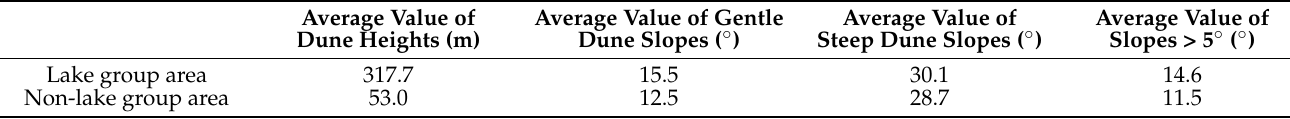
Table 2. Comparison between the dune heights and slopes in the lake and those in the non-lake group areas. Average Value of Average Value of Gentle Average Value of Average Value of Dune Heights (m) Dune Slopes ( ◦ ) Steep Dune Slopes ( ◦ ) Slopes > 5 ◦ ( ◦ ) Lake group